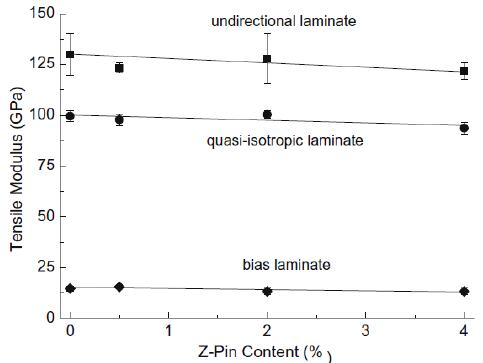
F igure 39. Effect of z-Pin content on tensile Figure 39. E ff ect of z-Pin content on tensile modulus due to z-Pinning on various lay-up laminates modulus due to z-Pinning on various lay-up (CFRP z-Pins, d = 0.28 mm, pre-preg) [16].